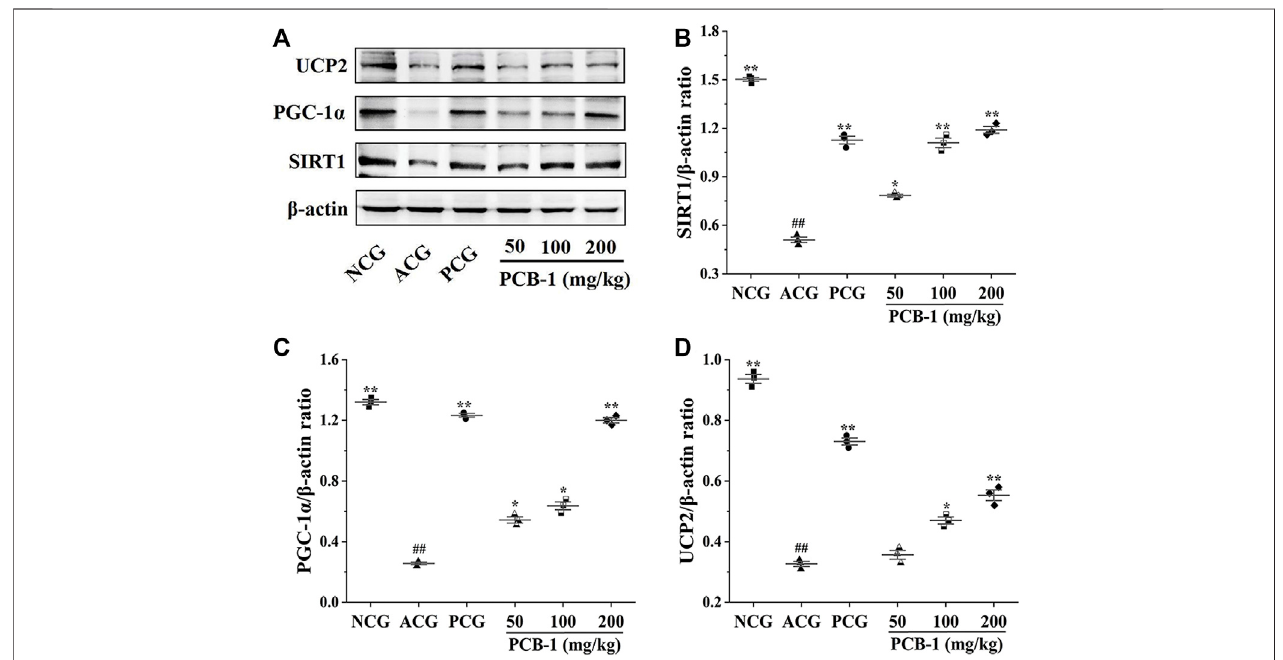
FIGURE 6 | Representative picture ofwestern blot bands and quanti fi cation of data showing the effects of PCB-1 alleviated oxidative stress in the liver of mice: (A) UCP2, PGC-1 α and SIRT1 expression in all experimental groups as evaluated by Western blotting; (B – D) Respective histograms of UCP2, PGC-1 α and SIRT1 protein expression using Image software. The gray value of the bands was normalised to β -actin ( n = 3). All bar graph data are presented as mean ± SD. # p < 0.05, ## p < 0.01 compared with normal control group; * p < 0.05, ** p < 0.01 compared with model control group.